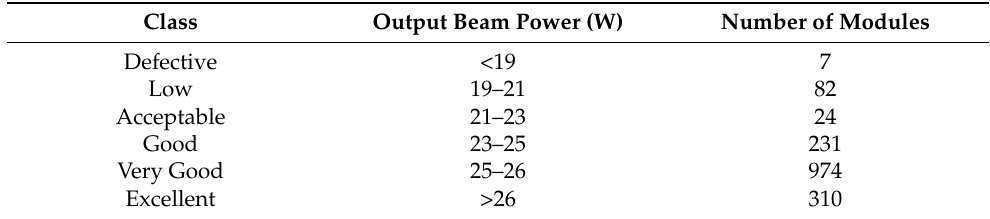
Table 4. Quality classes for the produced modules.